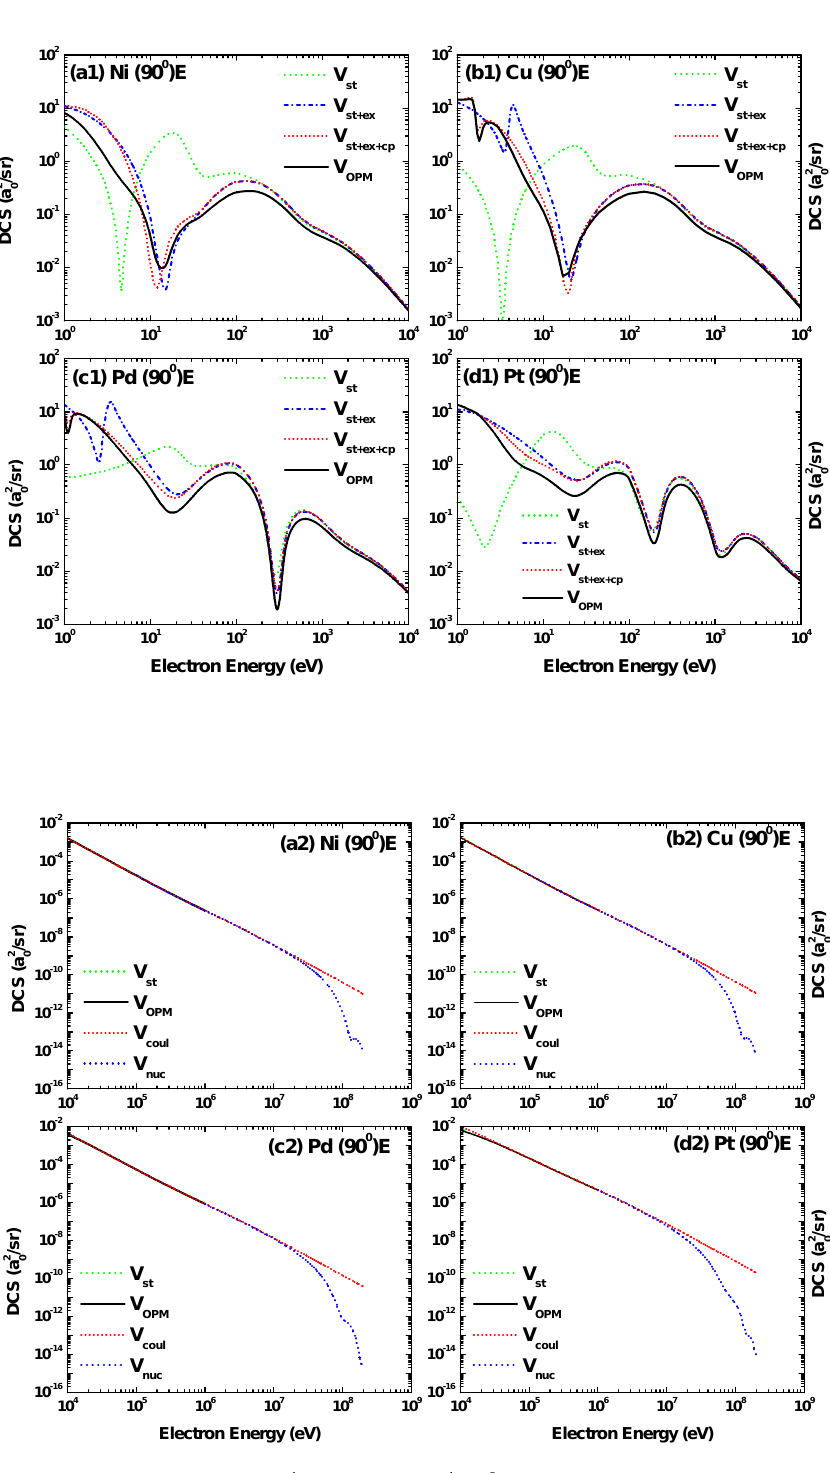
Figure 4. Energy dependence ( top : 1–10 4 eV, bottom : 10 4 –10 9 eV) of the differential cross-sections for electron scattering from ( a1 , a2 ) Ni 58 , ( b1 , b2 ) Cu 63 , ( c1 , c2 ) Pd 108 , and ( d1 , d2 ) Pt 196 at a fixed scattering angle θ = 90 ◦ . Shown in the top panels are the results from V st ( · · · · · · , green), V st + V ex ( − · − · − , blue), V st + V ex + V cp ( − − − , red), and V OPM (——, black). The bottom panels show the results from V st ( · · · · · · , green), V OPM (——, black), V c ( − − − , red), and V nuc ( · · · · ,